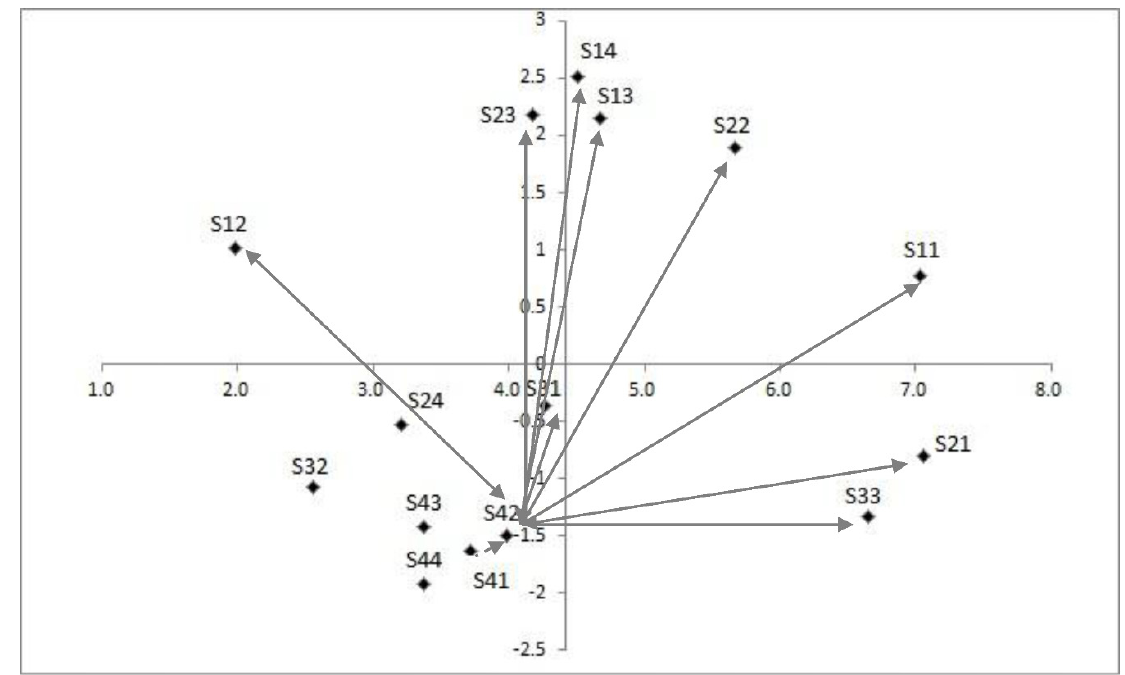
Figure A13. Casual Diagram between S42 and Other Criteria.